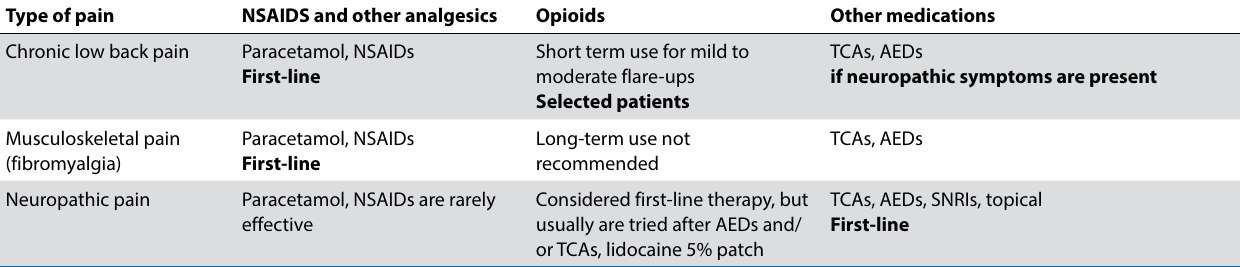
Table 1: Pharmacological management of chronic non-cancer or non-malignant pain 5